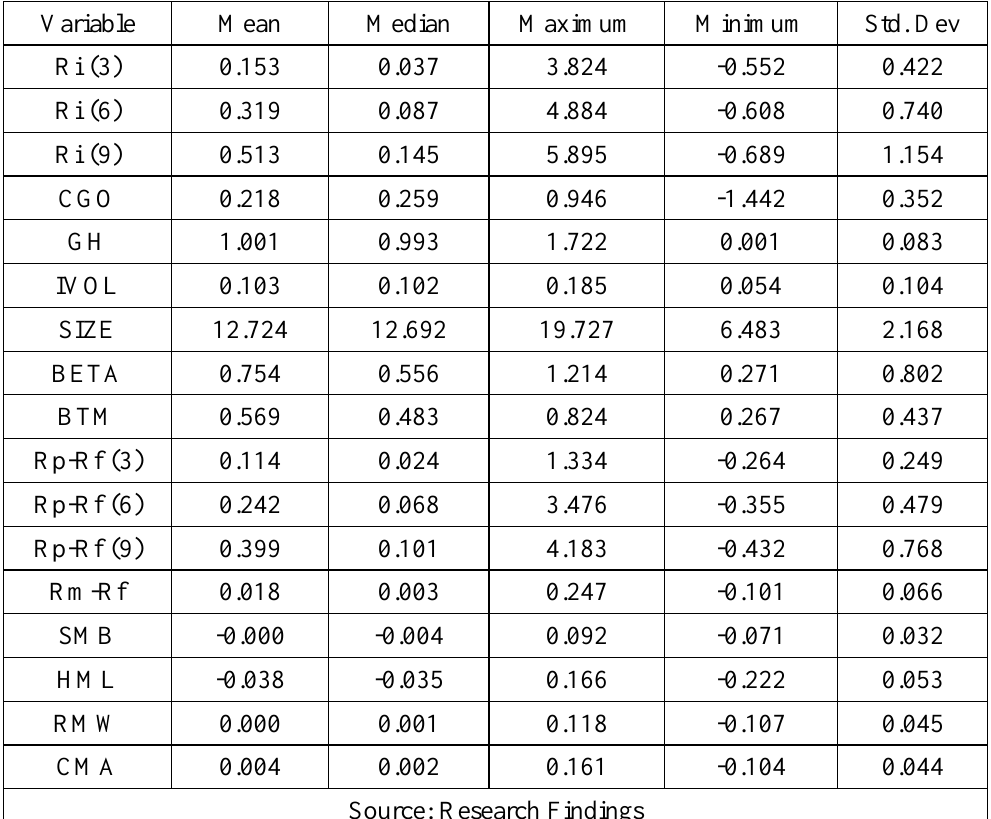
Table 1. Descriptive statistics of